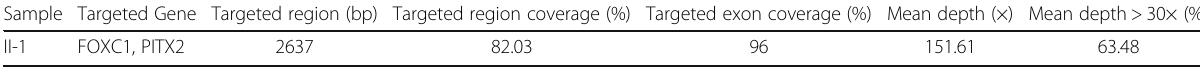
Table 3 Summary of the targeted exome sequencing results